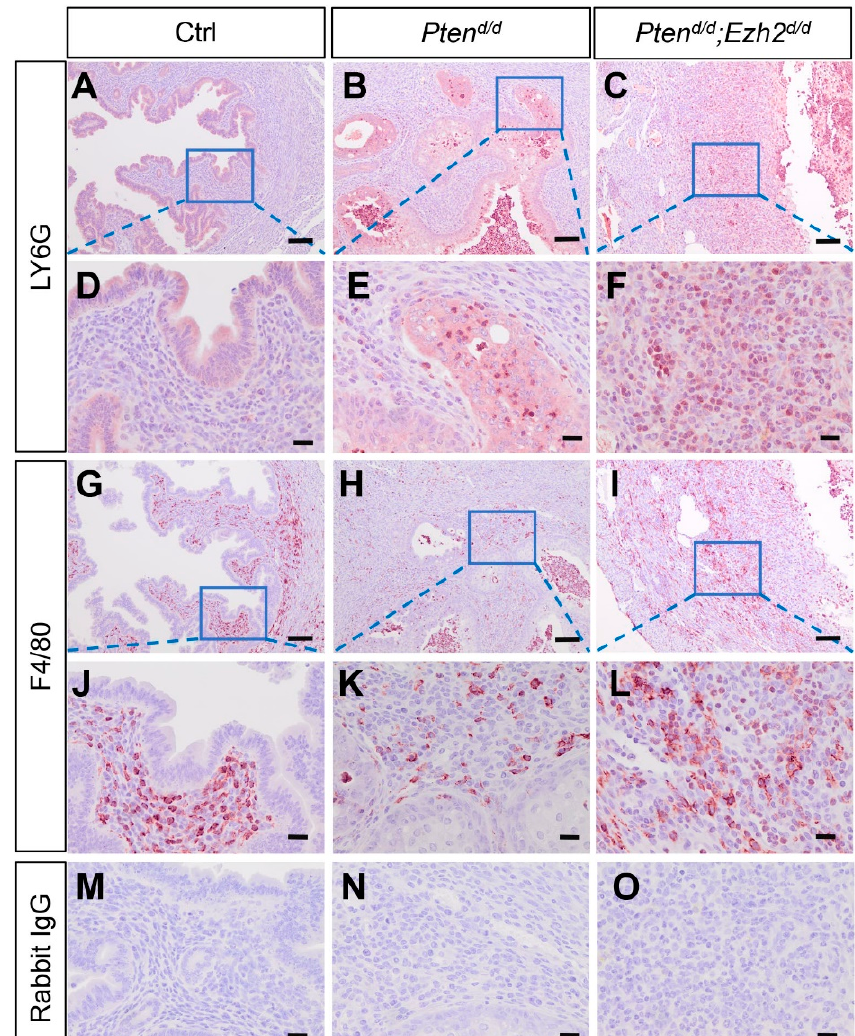
Figure 4. Deletion of Ezh2 in PTEN-inactivated uteri causes heightened inflammation. ( A – L ) Im- munostaining of LY6G and F4/80 in the uteri from nine-week-old Pten f/f , Pten d/d , and Pten d/d ; Ezh2 d/d mice. Panels ( D – F , J – L ) are high power images of the boxed areas of panels ( A – C , G – I ), respectively. ( M – O ) Negative controls where the primary antibody was replaced with isotype–matched IgG. At least three independent mice per group were examined. Scale bar = 100 µm ( A – C , G – I ) and 20 µm ( D – F , J – O ).